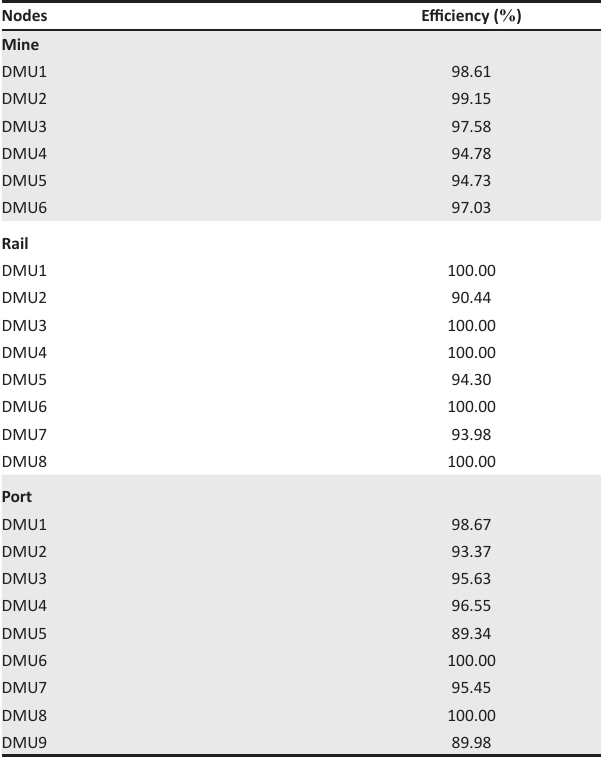
TABLE 1: Efficiency